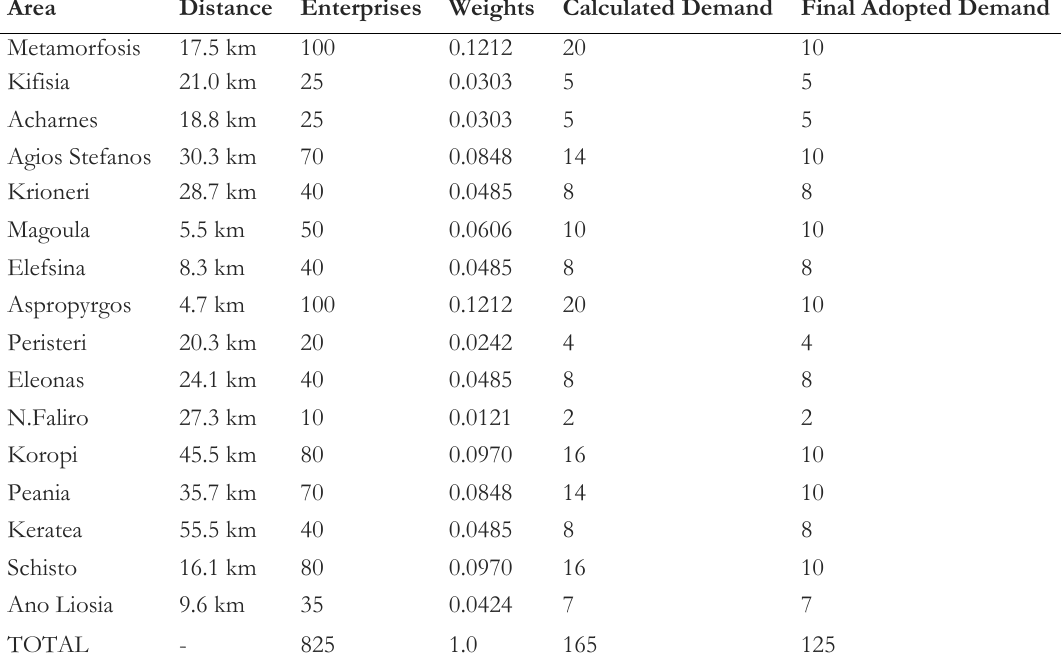
Table 2. Characteristics of industrial/commercial